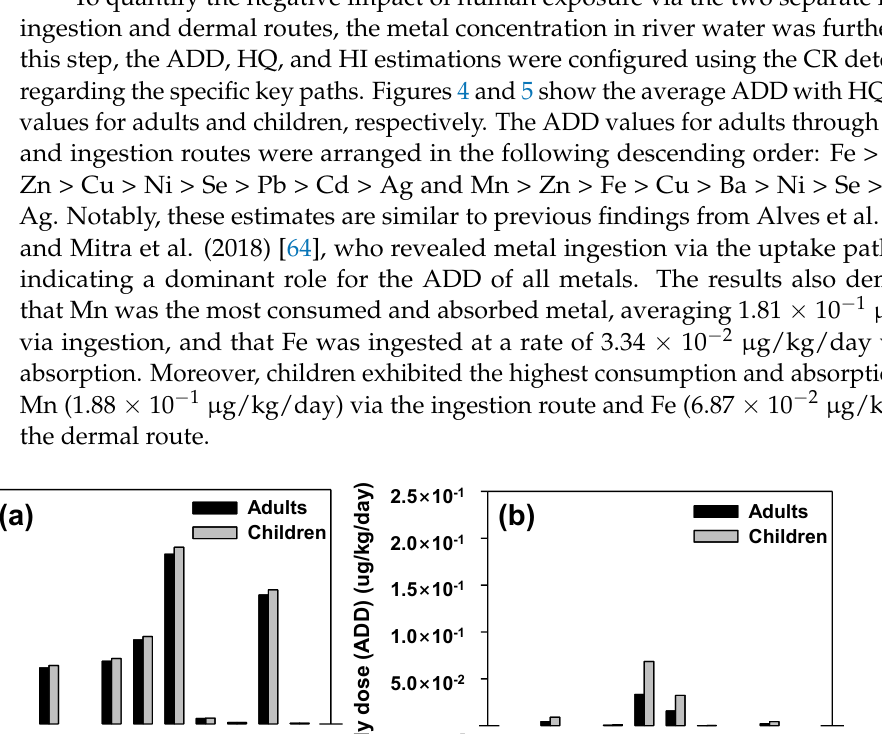
Figure 5. Hazardous quotient (HQ) for both ( a ) ingestion rate and ( b ) dermal adsorption of adults and children in the Han River watershed. HQ quantifies the non-carcinogenic risk through various important pathways for adult s and children. The following rankings were identified for the mean HQ values across all age groups in Figure 5: Mn, Cu, Pb, Zn, Ni, Ba, Se, Fe, Cd, and Ag (ingested) , and Mn, Ba, Fe, Ni, Cd, Cu, Zn, Pb, Se, and Ag (dermal). Moreover, Mn exhibited values of 7.55 × 10 −3 and 7.85 × 10 −3 for adults and children, respectively, and the highest values of HQ (uptake) were identified , while Mn had the highest HQ (dermal), with values of 1.64 × 10 − 2 for adults and 3.37 × 10 − 2 for children. In a previous study, considering two different types of communities, the children ’ s HQ (ingestion) values were marginally higher than those of adults from Saha et al. (2017)[65]. Unexpectedly, unlike the ingestion and dermal contact, a more than two-fold difference between adults and children was identified. Namely, although the surface area (SA) of adults was three times larger, the average time (AT) was ~ 10 times larger, thus manifesting high values of the dermal HQ in children [66] . For both adults and children in the Han River watershed, the non-carcinogenic risk associated with combined ingestion and dermal exposure to Ag, Ba, Cd, Cu, Fe, Mn, Ni, Pb, Se, and Zn did not exceed the safety limit (HI < 1.0), as seen from Figure 6a. For both adults and children, Mn exhibited the highest HI, followed by Cu, Pb, Ba, Zn, Fe, Ni, Se, Cd, and Ag. As a result, the HI values below 1 for all the measured metals do not necessarily indicate a risk to human health. Notably, the HI value for children was 1.65 times higher than that for adults, thereby suggesting potentially higher vulnerability for children to non-carcinogenic risks from trace elements [67].